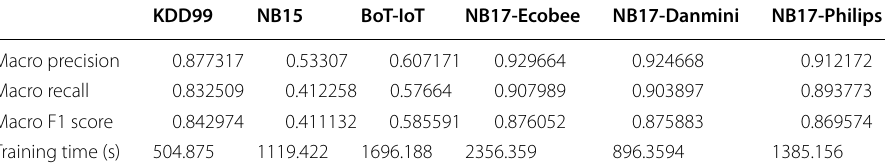
Table 9 ANN classification results on Scikit-Learn on local machine (no resampling)